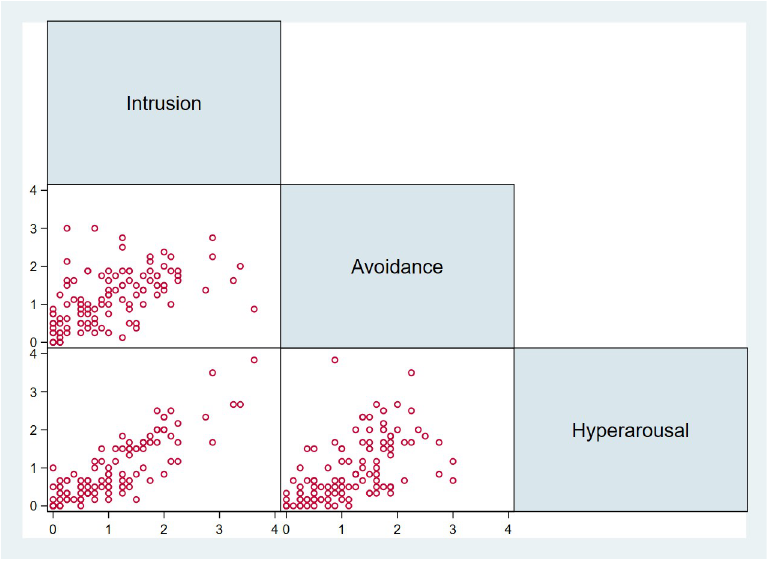
Fig 2. A scatter plot matrix that shows the relationship among the three